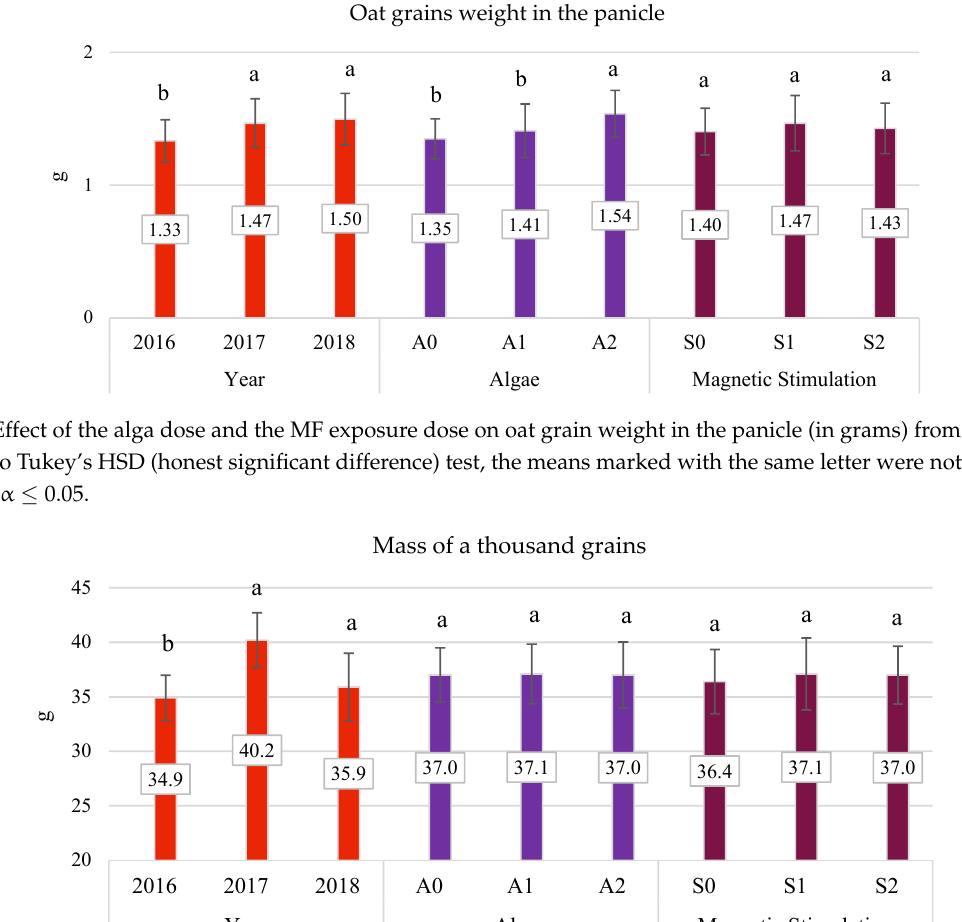
Figure 11. Effect of the alga dose and the MF exposure dose per mass of a thousand grains from 2016 to 2018. According to Tukey’s HSD (honest significant difference) test, the means marked with the same letter were not significantly different at α ≤ 0.05.